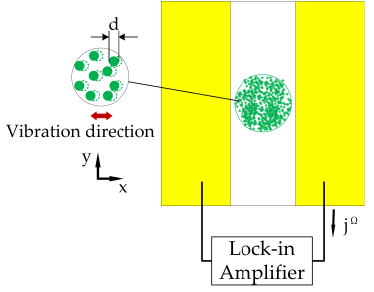
Figure 1. Principle of in-plane vibration measurements based on GaAs.